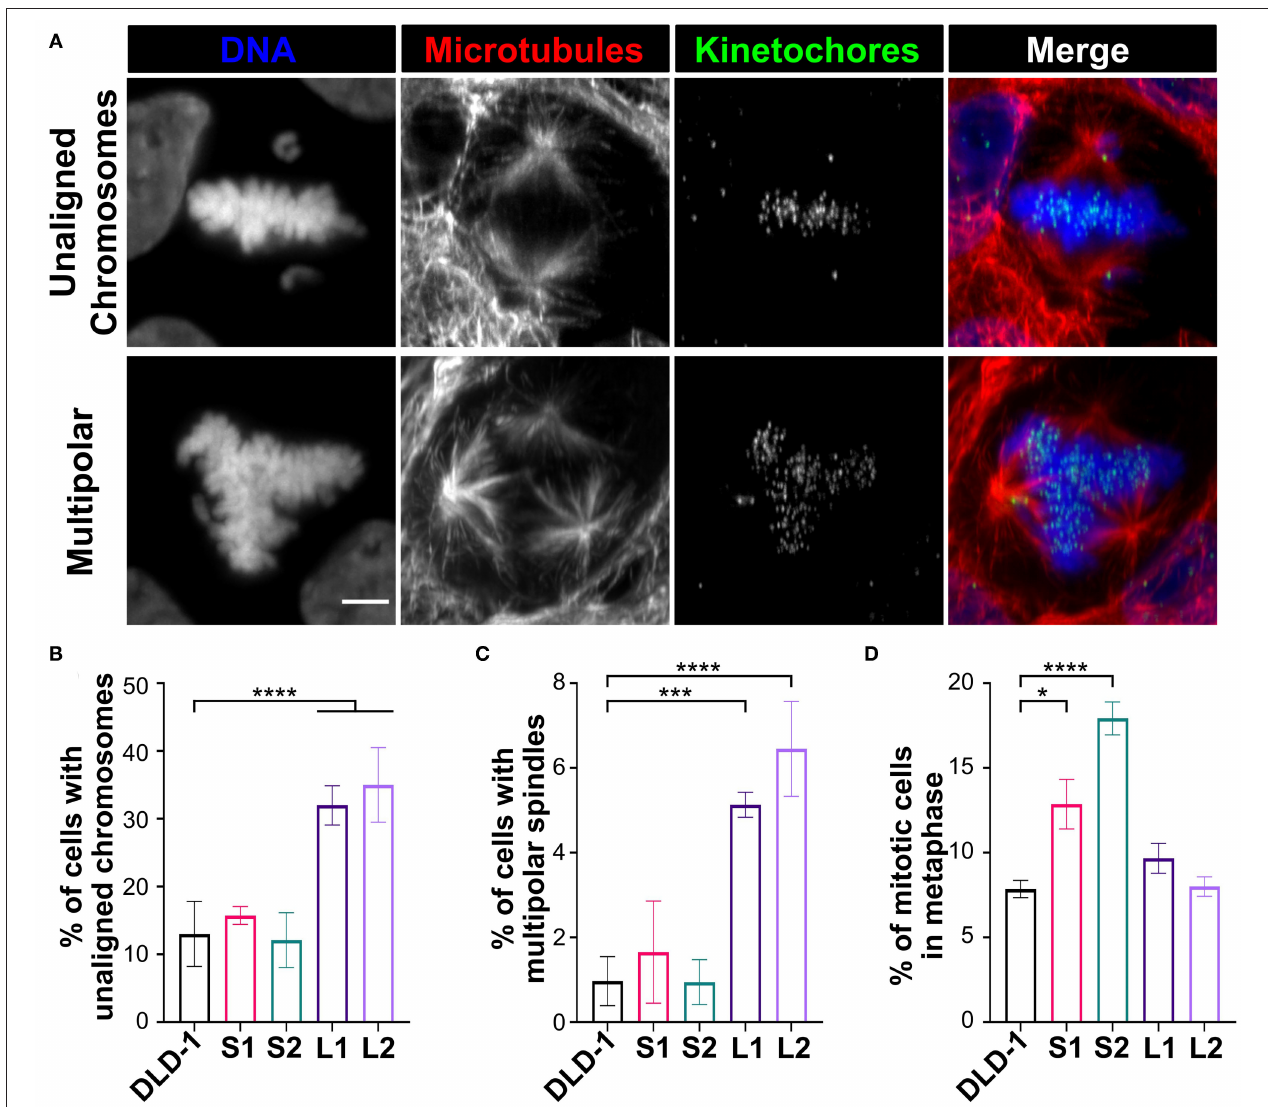
FIGURE 4 | Defects in prometaphase do not cause the mitotic delay in small 4N DLD-1 clones. (A) Examples of a cell with unaligned chromosomes (top) and a multipolar spindle (bottom). Scale bar, 5 µ m. (B–D) Quantification of the percentage of late prometaphase-metaphase cells with (B) unaligned chromosome(s) and (C) multipolar spindles. (D) Quantification of the percentage of mitotic cells in metaphase. Graphs for panels (B–D) represent the mean experiments where at least 100 cells were scored in each experiment ( n > 300 for each cell line). * p < 0.05, *** p < 0.001, **** p < 0.0001, when compared to parental DLD-1 cells using a two-sided Fisher’s exact